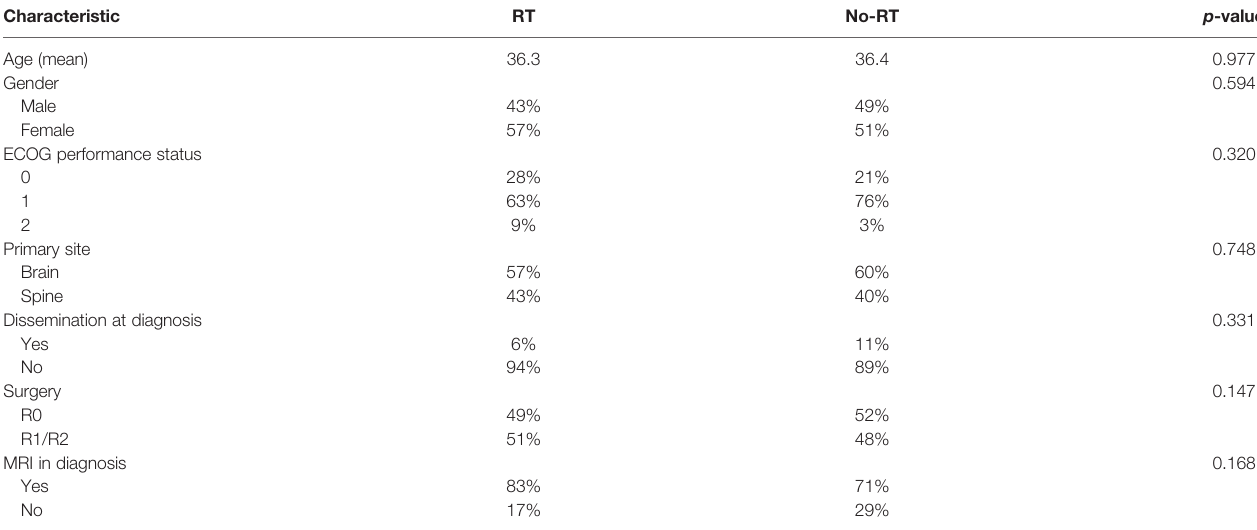
ECOG, Eastern Cooperative Oncology Group; MRI, magnetic resonance imaging; R0, radical resection (macro- and microscopically); R1, macroscopically radical resection (but not microscopically); R2, macroscopically nonradical resection.